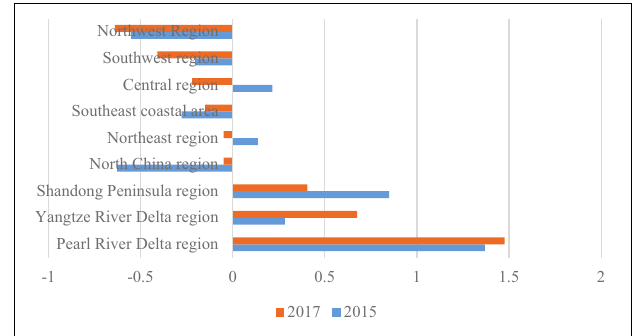
FIGURE 2 | Analysis of the level of competitiveness of the nine major logistics regions.